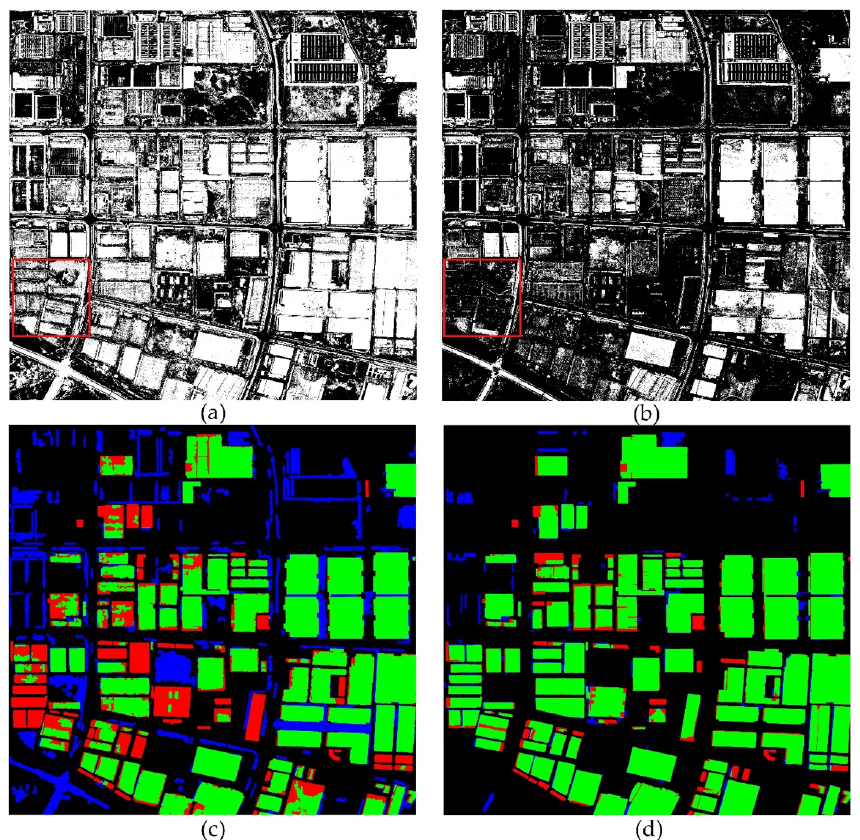
Figure 10. Comparison evaluation: ( a , b ) changes obtained by combining pixel-based detection and object-based recognition (CPDOR) when T S = 0.5 and T S = 1; ( c ) overlay between CPDOR result and ground truth, and ( d ) overlay between results of this study and ground truth. Green represents correct detection, red represents missing detection, and blue represents false detection. Table 2. Change detection confusion matrix.